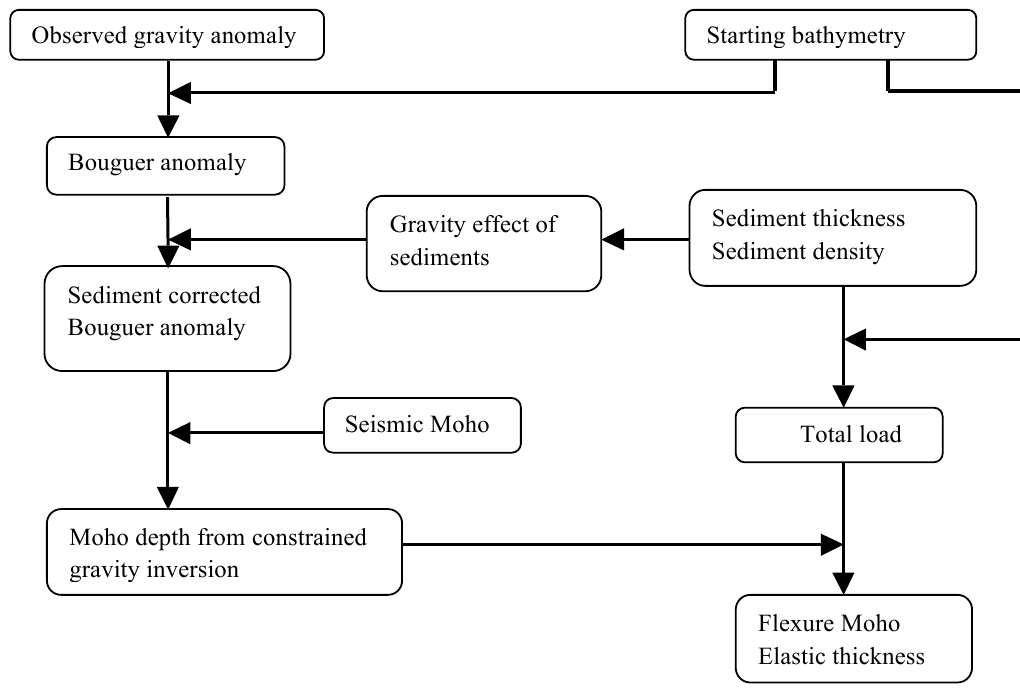
Figure 3. Flowchart illustrating the steps of the modeling and inversion procedures (modified from Braitenberg et al. [2006]).